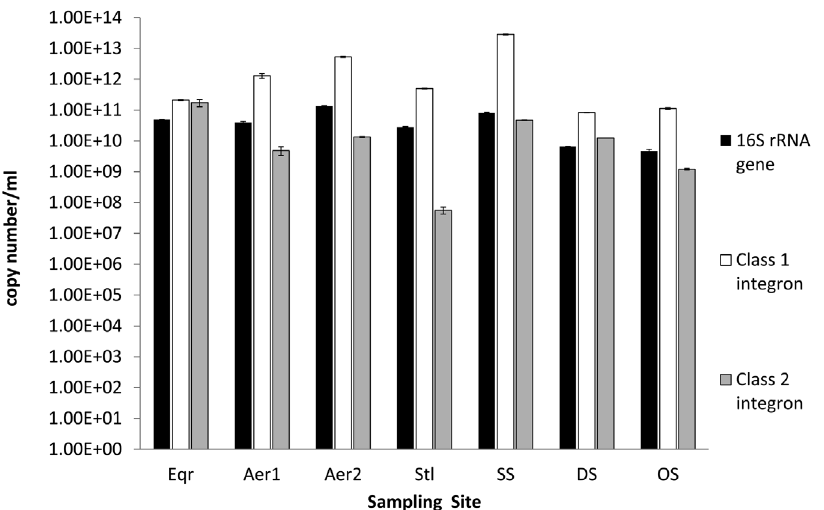
Figure 2. Comparison of bacterial 16S rRNA gene copy number and copy numbers of integron classes 1 and 2. The error bars represent standard deviations of three technical replicates. Abbreviations: Eqr = equilibratior; Aer1 = aeration tank No. 1; Aer2 = aeration tank No. 2; Stl = settling tank; SS = secondary sludge; DS = dewatered sludge; OS = old dried sludge.